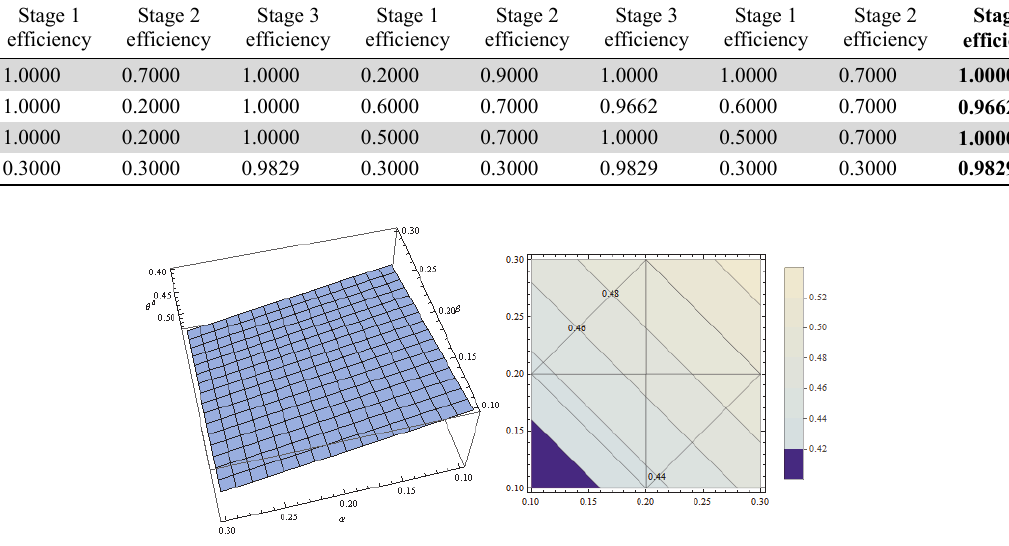
Model (18) Model (17) Model (16)